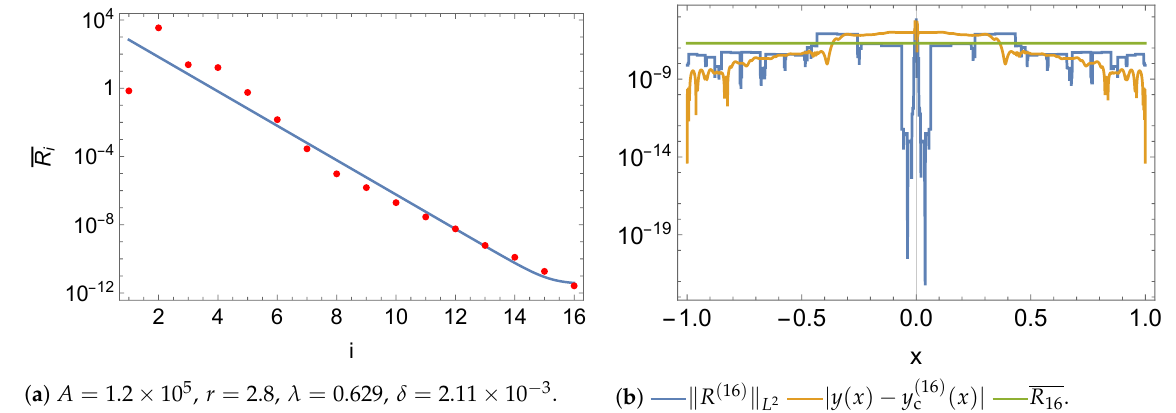
Figure 19. ( a ) Fitting the upper bound (24) with the set R . ( b ) Visualization of the residual, absolute local approximation error, and the mean